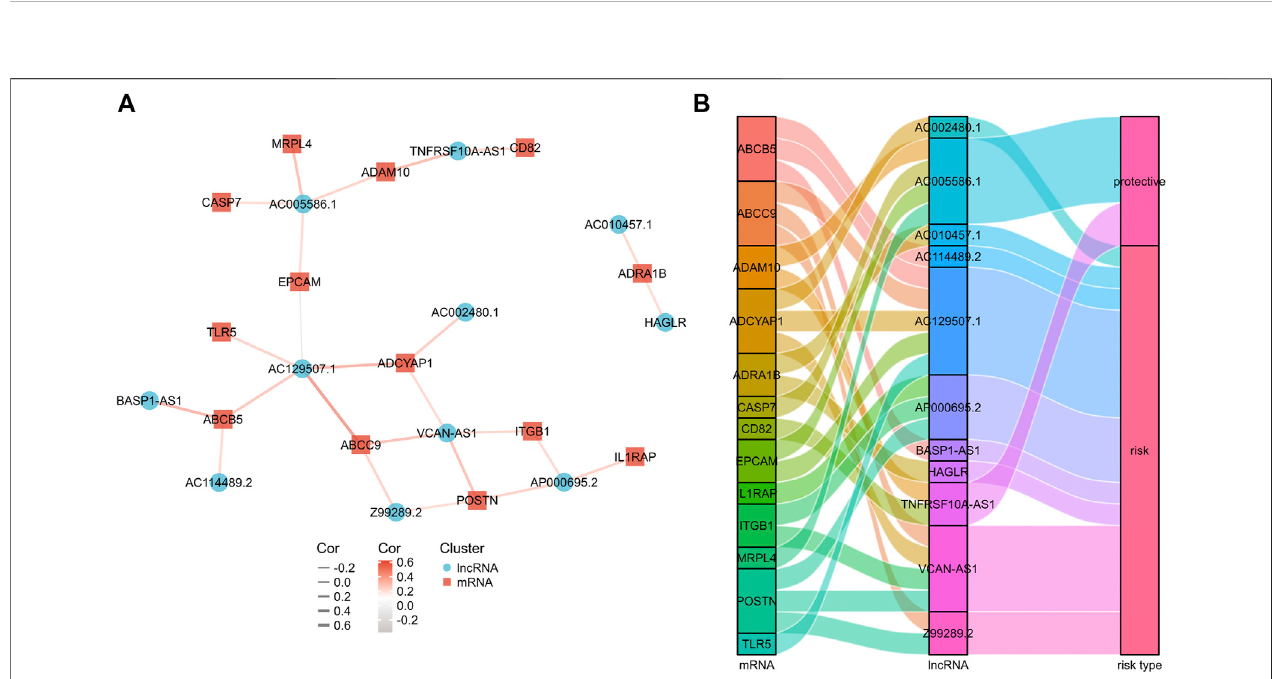
FIGURE 2 | The mRNA-lncRNA co-expression network. (A) mRNA-lncRNA co-expression network of the exosomes-related genes and the selected exosomes- related lncRNAs. (B) The Sankey diagram showing the connection degree between the exosomes-related lncRNAs and the exosomes-related genes.